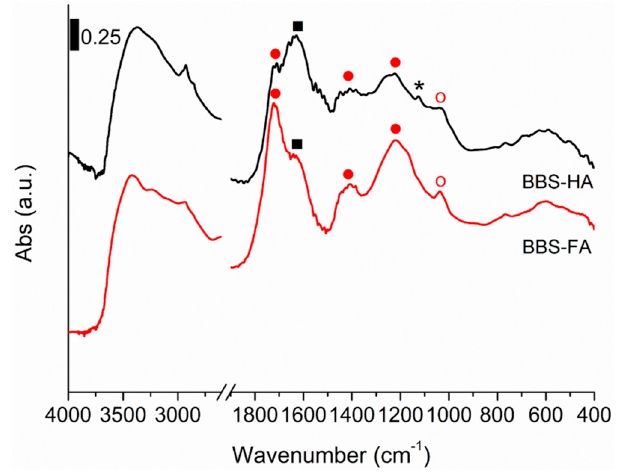
Figure 1. Absorbance FTIR spectra in the 4000–400 cm − 1 range of BBS-HA (solid black curve), and BBS-FA (solid red curve). The main relevant peaks are labeled. Legend: aromatic C=C (black square), O-containing functional groups (red circle), polysaccharide-like impurities (white circle), and alcoholic/ether C–O (black star).